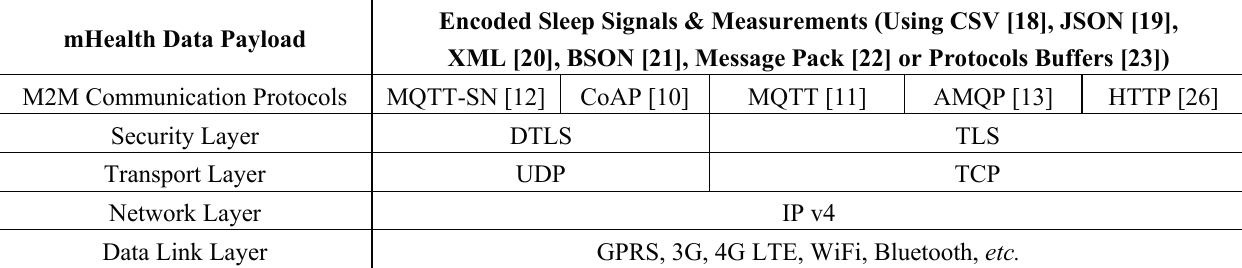
Table 5. The proposed mHealth data encoding, communication and security framework. mHealth Data